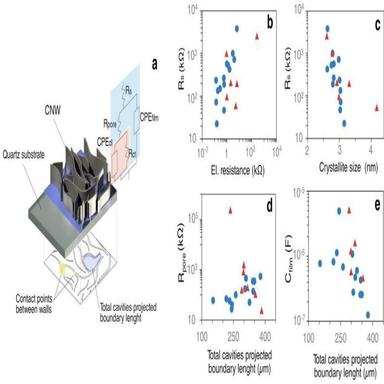
(a) Schematic of the BCWN samples with the equivalent circuit (EC). Correlations between the electric resistance (b), the crystallite size (c) and the value of Rs. Correlation between the outer elements of the EC -film capacitance (d) and pore resistance (e) and the total projected cavities boundary length, estimated by SEM.